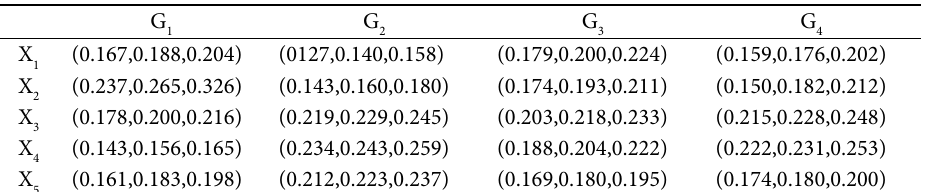
Table 11. Decision matrix R 